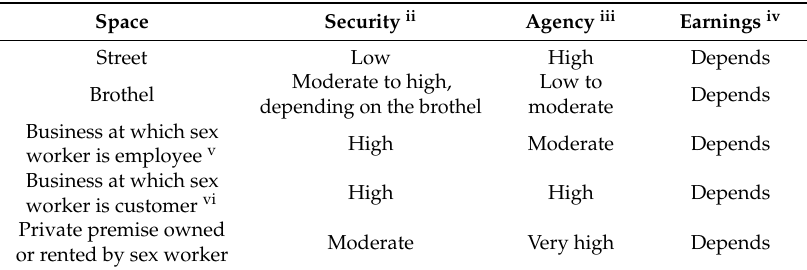
Table 6. Levels of security, agency, and earnings in different sex work spaces.